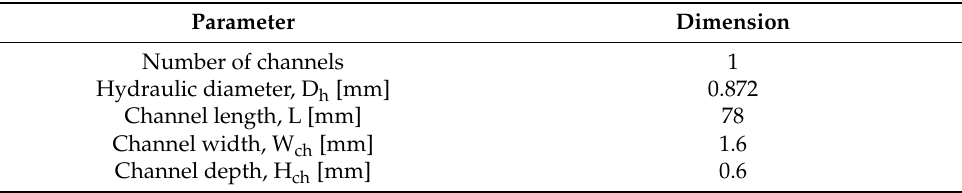
Table 1. Dimension parameter of micro